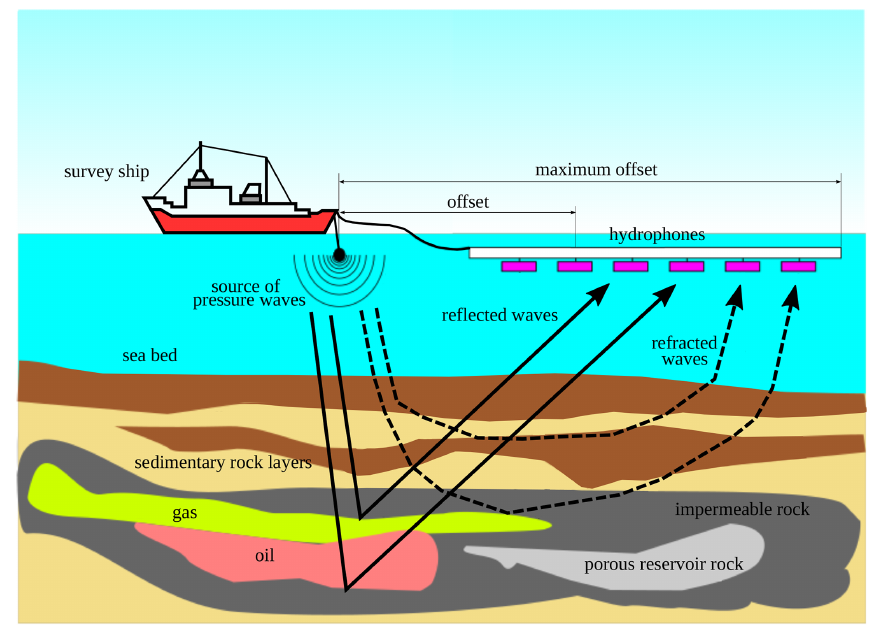
Figure 1. A simplified illustration of a marine seismic survey with relevant components annotated. Courtesy from João Baptista Dias